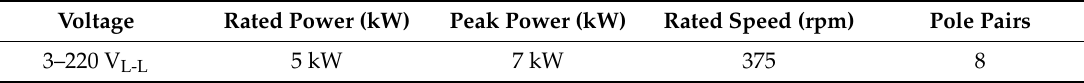
Table 1. Technical characteristics of the electrical generator used in the small wind turbine. Voltage Rated Power (kW) Peak Power